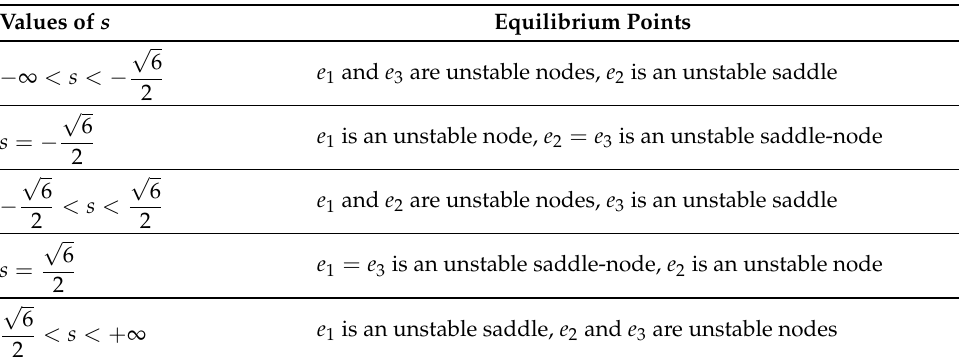
Table 1. Equilibrium points for the different values of s , where e 1 = ( 1,0 ) , e 2 = ( − 1,0 ) and √ e 3 = ( 2 s / 6,0 )